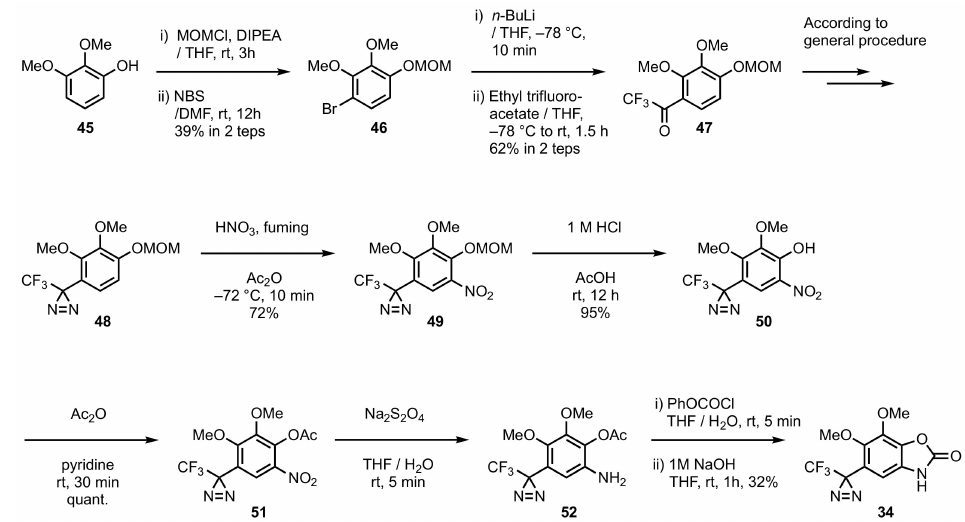
Scheme 7. The synthesis of diazirinyl-substituted benzoxazolinone analogue